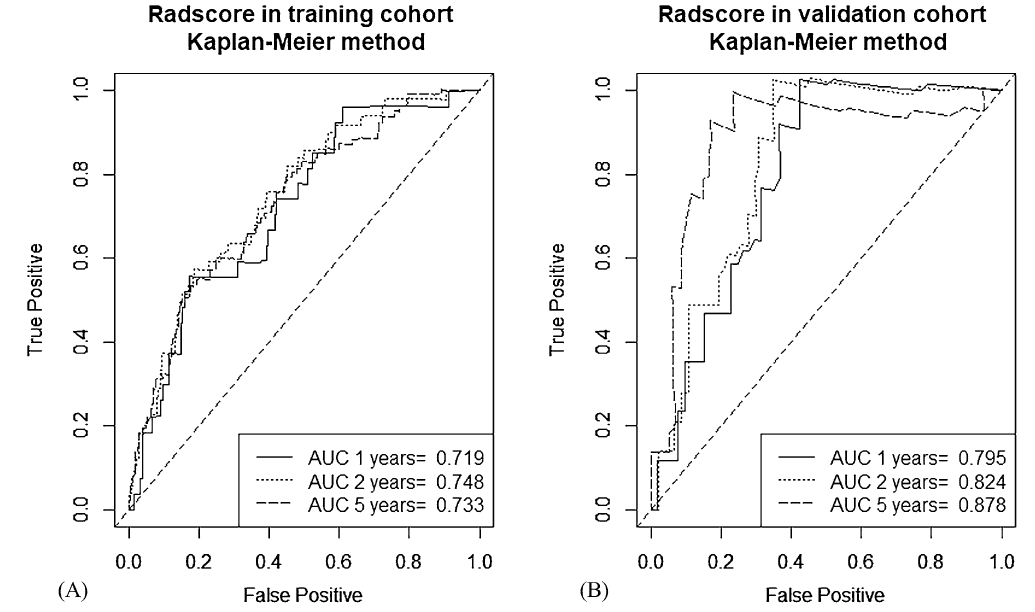
Figure 2. Survival receiver operating characteristic curves at 1, 2, and 5 years with the radscore, ( A ) in training cohort and ( B ) in validation cohort. R software (version 3.3.2, https ://www.r-proje ct.org) was used to draw.